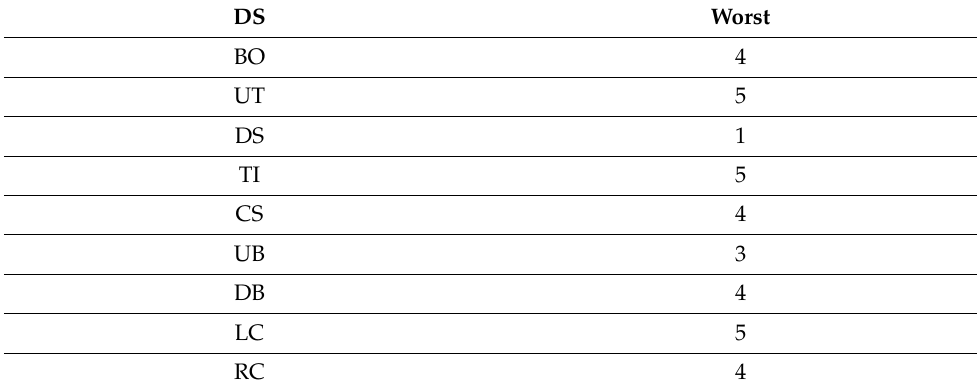
Table 6. Worst criteria preferences.